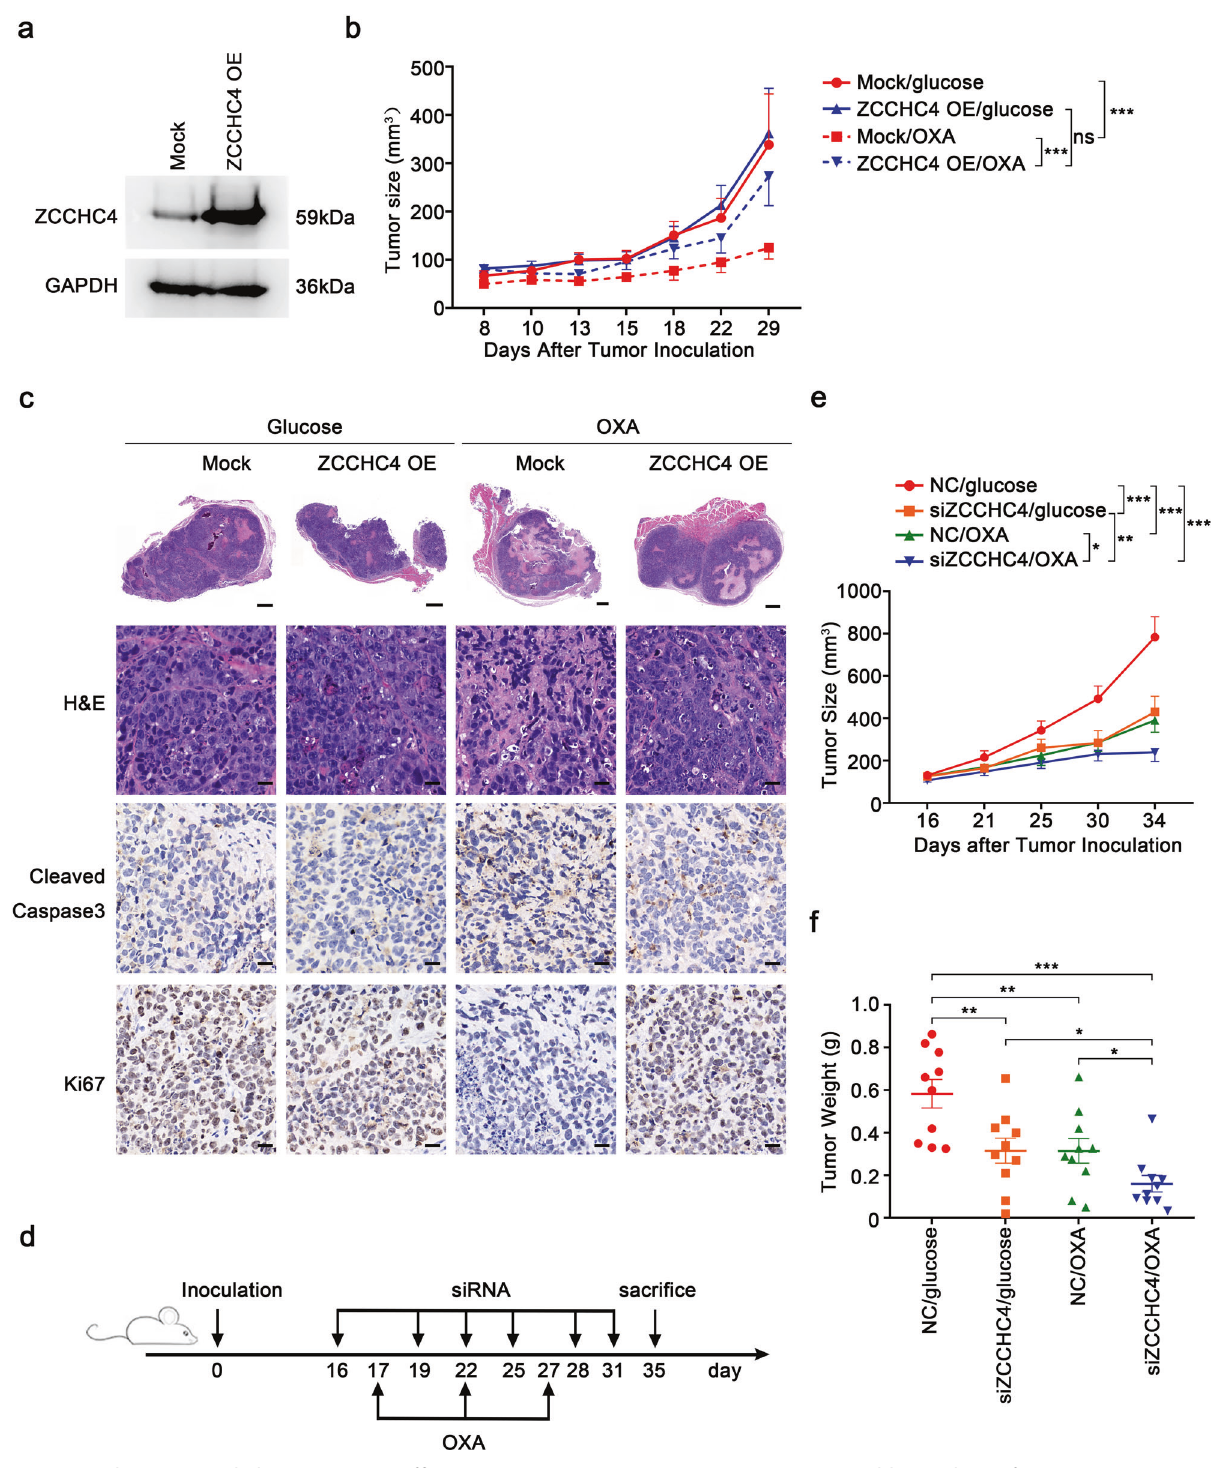
Fig. 3 ZCCHC4 hampers oxaliplatin treatment ef fi ciency in HCC in vivo. a Representative immunoblot analysis of ZCCHC4 protein in mock cells and cells stably overexpressing ZCCHC4 (ZCCHC4 OE). b , c Nude mice were inoculated subcutaneously with 1 × 10 7 ZCCHC4- overexpressing or mock cells and intraperitoneally injected with 10 mg/kg OXA or 5% glucose once a week for three times since day 10 after tumor inoculation (day 0). Tumor growth of mice ( n = 7 for mice bearing mock cells with 5% glucose treatment or OXA treatment; n = 12 and n = 10 for mice bearing ZCCHC4 OE cells with 5% glucose treatment or OXA treatment respectively; pooled from two independent in vivo experiments) ( b ) and representative H&E and IHC photographs of tumor tissues (scale bars in top row, 500 μ m; scale bars for others, 20 μ m) ( c ) were shown. b *** P < 0.001; ns, not signi fi cant (two-way ANOVA test). d – f Nude mice were inoculated subcutaneously with 1 × 10 7 HepG2 cells and received intratumor injection of siRNA (10 nM each mouse) and peritoneal injection of OXA (5 mg/kg) 16 days after tumor inoculation. The scheme was shown in d , and the tumor growth ( e ) and tumor weight ( f ) of mice ( n = 10 for each group, pooled from three independent in vivo experiments) were measured. * P < 0.05; ** P < 0.01; *** P < 0.001 ( e two-way ANOVA test; f unpaired Student ’ s t test)